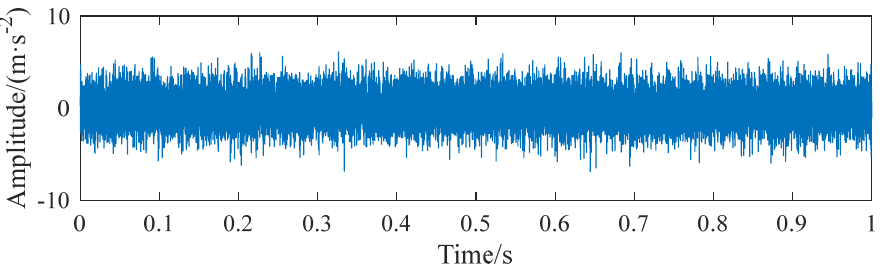
Figure 3. Simulated fault signal with noise.